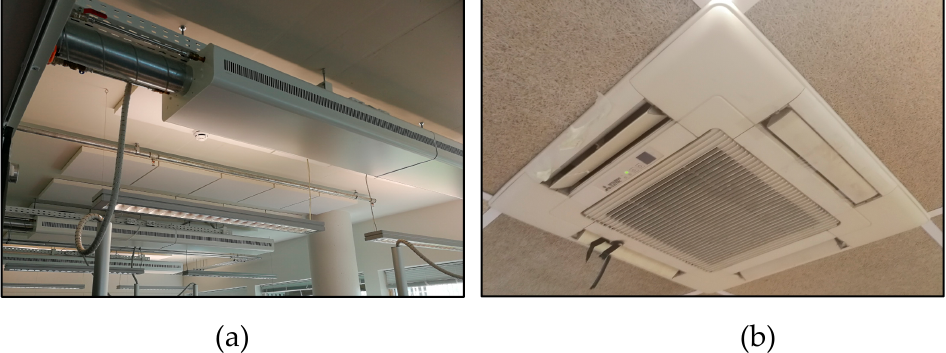
Figure 3. Possible air flow obstacles with open active beam solution ( a ); modified airflow distribution with fan coil unit ( b ).